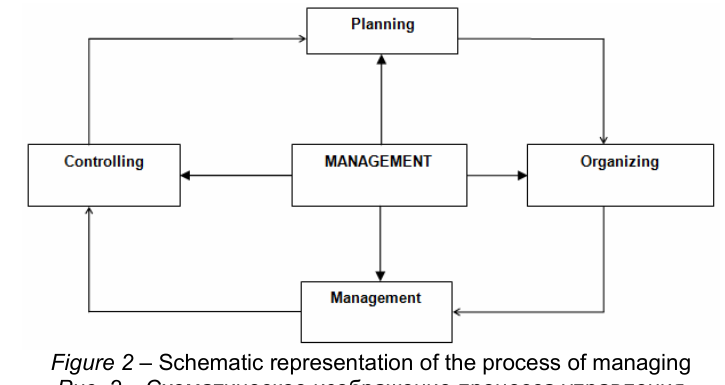
Figure 2 – Schematic representation of the process of managing Рис . 2 – Схематическое изображение процесса